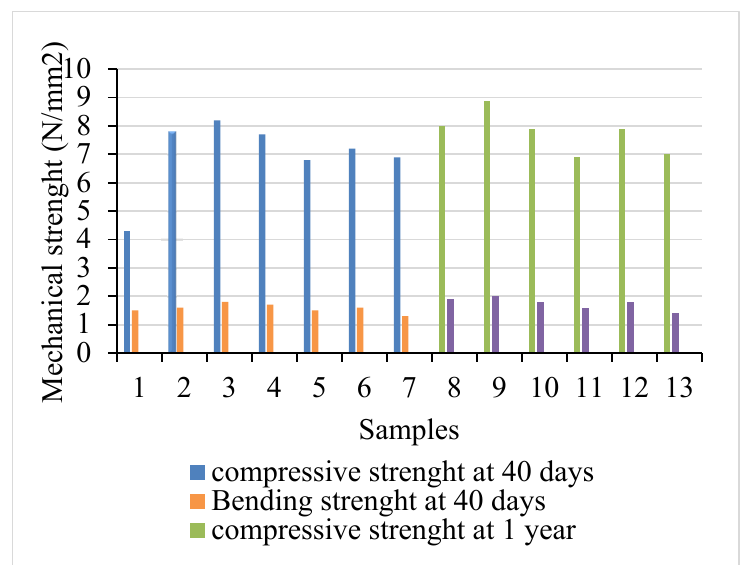
Figure 5. Mechanical resistance of samples.